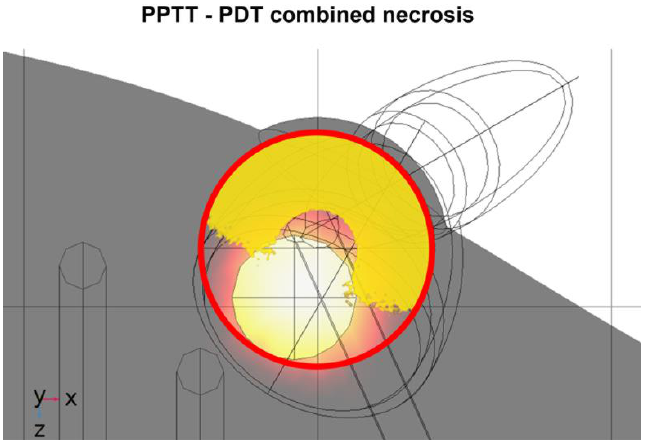
Figure 6. Necrotic area for the PPTT – PDT combined treatment scheme, as the fusion result of Figures 3d and 5a. The total necrotic percentage is ~99.3%. The tumor is highlighted in a red circle, for reasons of clarity.